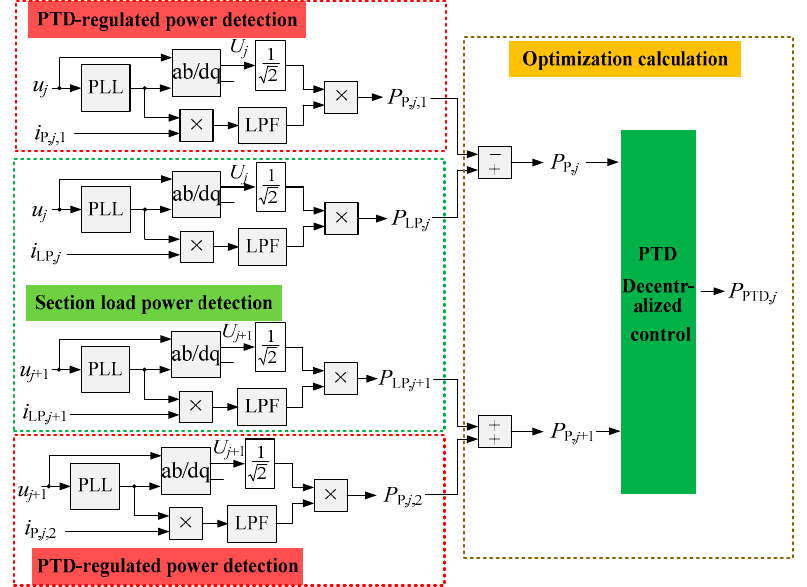
Figure 17. Detection block diagram in decentralized control of PTD.